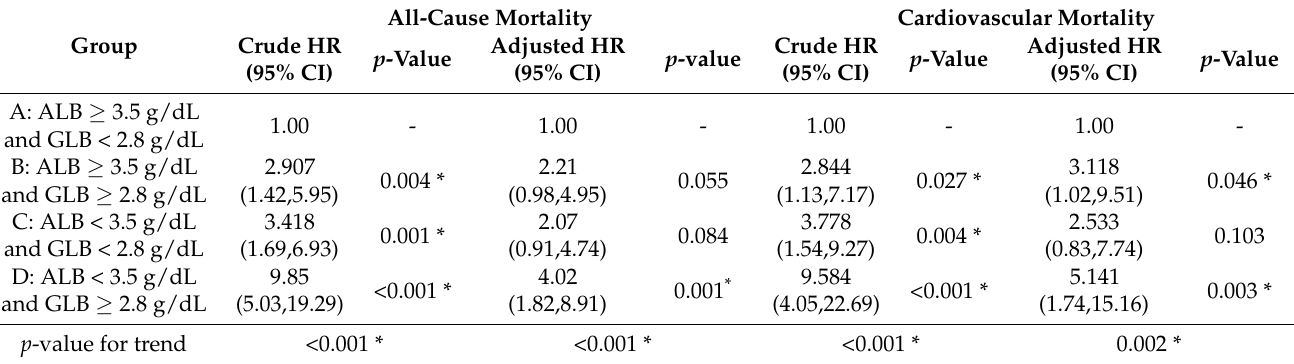
Table 4. Sensitivity